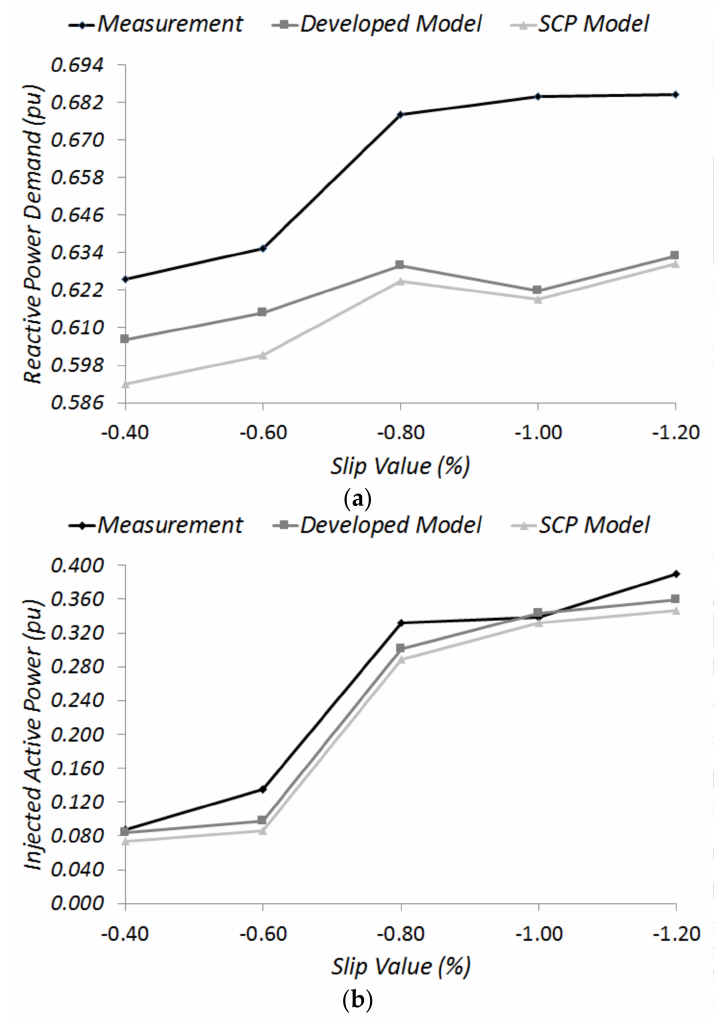
Figure 7. Variation of the reactive power demand ( a ), and injected active power ( b ) of the generator at the 2% VUF value for different rotor slip